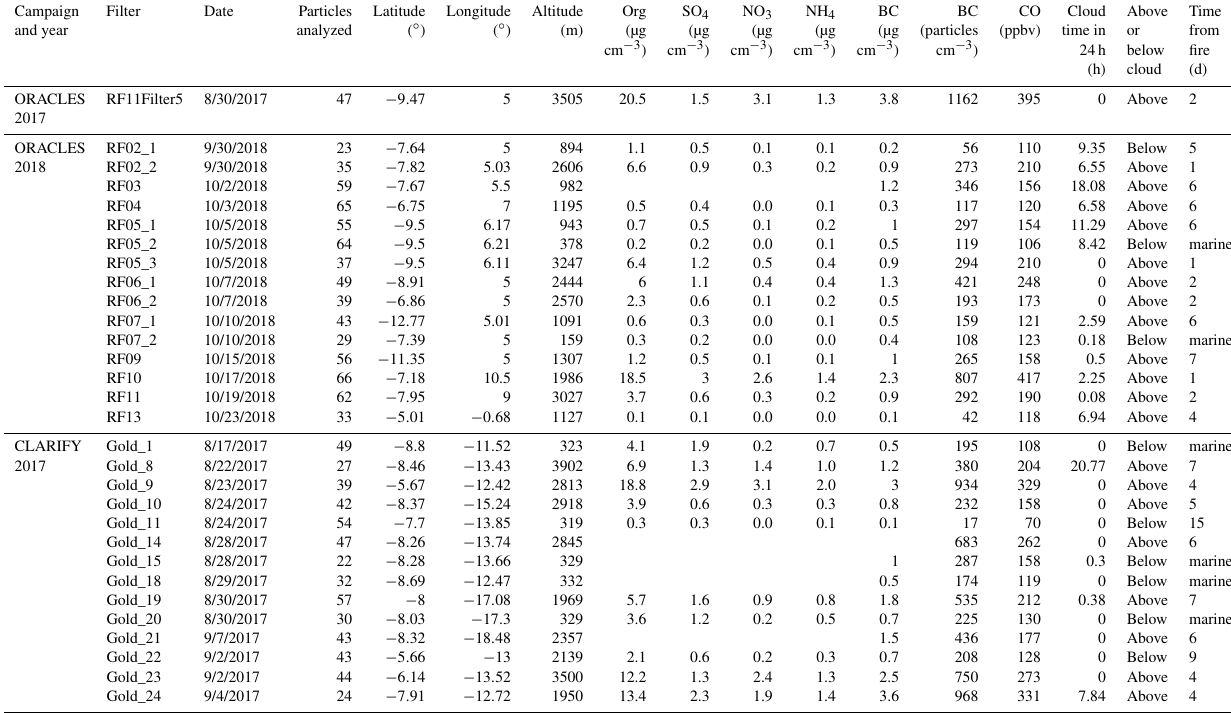
Table 1. Filter IDs, ancillary online aerosol data, location, altitude, back-trajectory-based time from fire as detailed in the text, and in-cloud time over previous 24h. Campaign